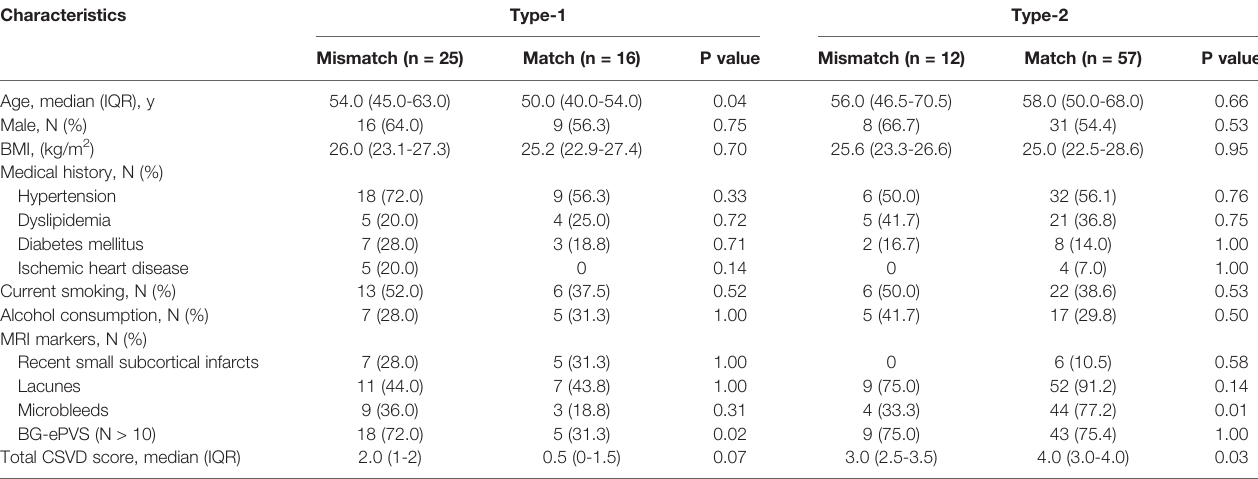
TABLE 4 | Clinical and imaging factors related to type-1 mismatch and type-2 mismatch.